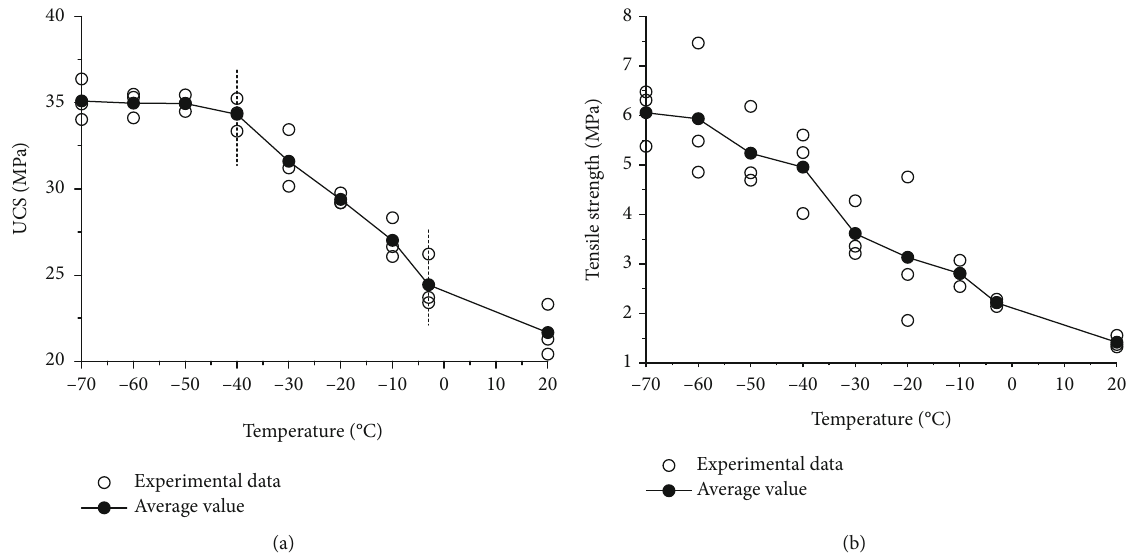
Figure 2: Evolutions of UCS and tensile strength with temperature: (a) UCS and (b) tensile strength.